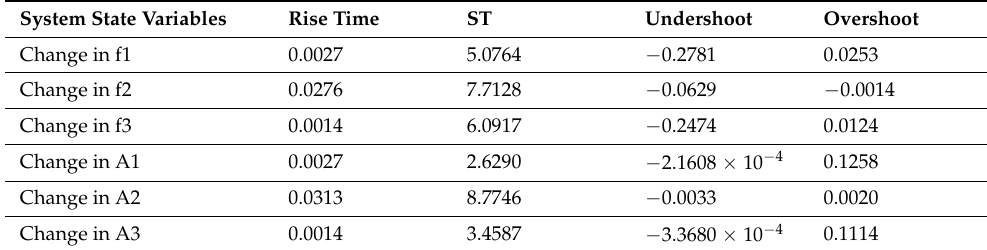
Table 5. Transient response of AGC performance evaluationfor